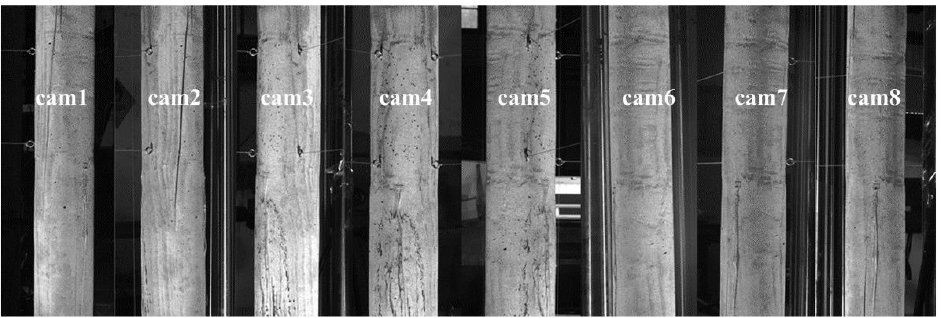
Figure 17. Local region captured by each camera.